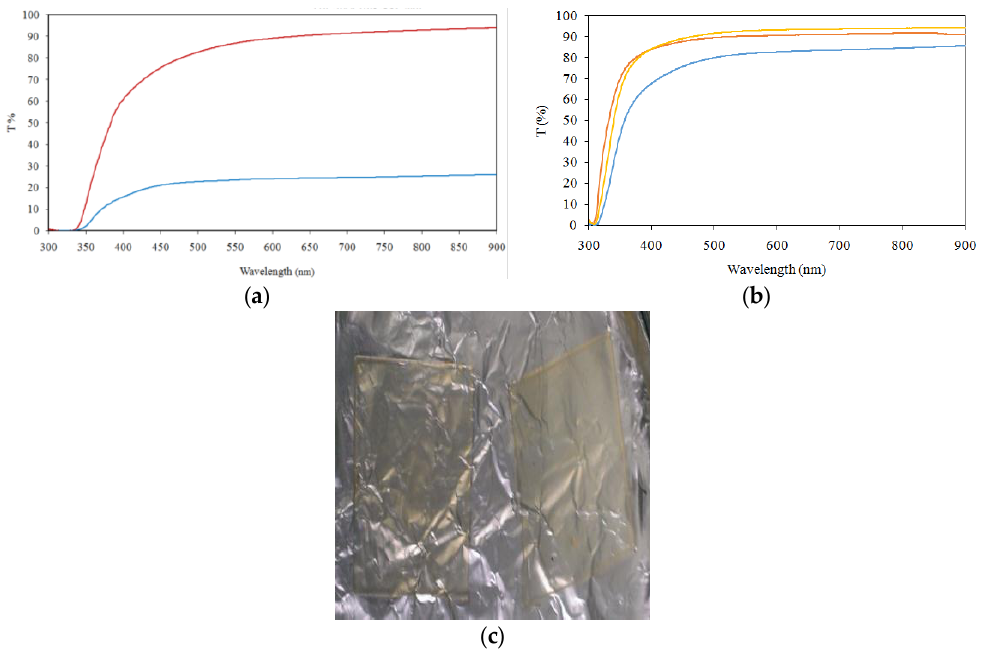
Figure 6. Ultraviolet–visible (UV-vis) spectra of ( a ) poly(Ti–O–Si precursor) ( – ) (6.75 μm) and poly(Ti–O–Si precursor-co-OPPEA) hybrid films ( – ) (6.77 μm) and ( b ) poly(Ti–O–Si precursor-co-OPPEA) hybrid films with different thicknesses ( – ) 2.59, ( – ) 6.77, and ( – ) 11.75 μm. ( c ) Photograph of poly(Ti–O–Si precursor-co-OPPEA) hybrid film (2.59 μm).